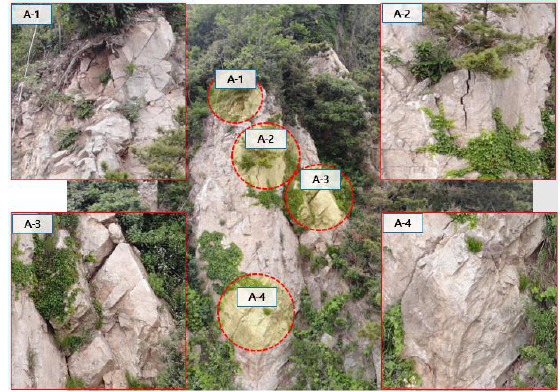
Figure 7. Close-up captured drone aerial imagery of inaccessible steep slope